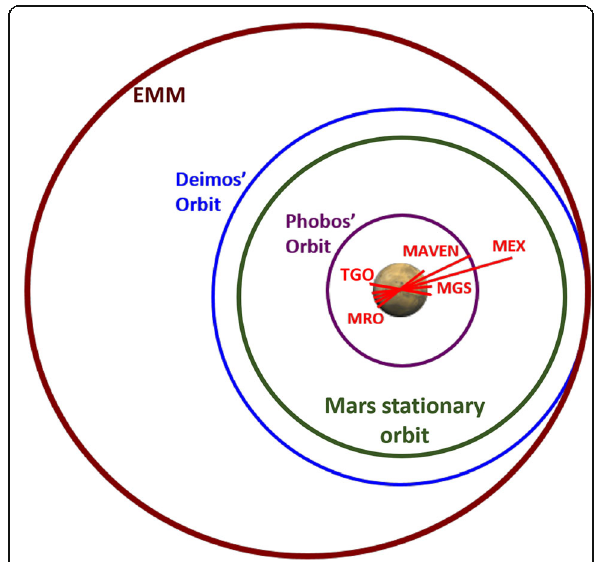
Fig. 2 Illustration of the orbits of TGO, MGS, MRO (Mars Reconnaissance Orbiter), MAVEN, Mars Express (MEX), EMM, and possible future Mars stationary satellite(s). The orbit of EMM and Mars stationary orbit are higher than those of the other missions. In addition, the orbits of the Mars moons Deimos and Phobos are shown. Adapted from Sharaf et al. (2017)